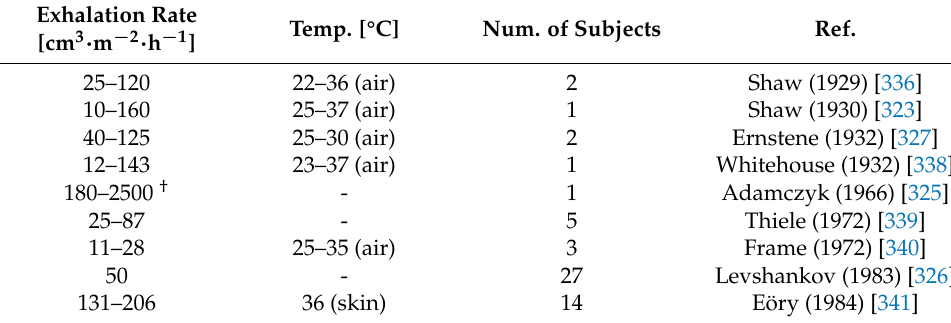
Table 2. CO 2 exhalation rate through the skin in the